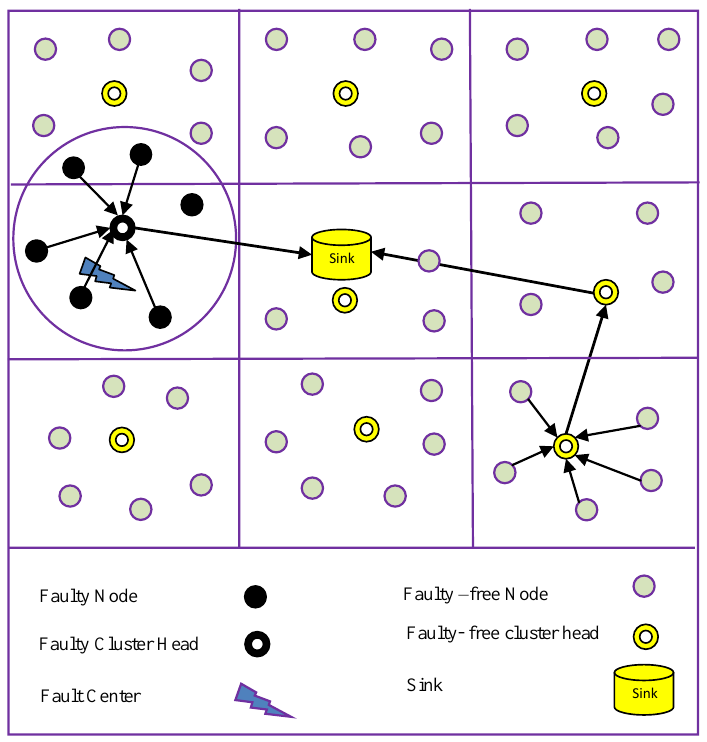
Figure 3. Wireless sensor network with fault-free and faulty nodes and cluster head.